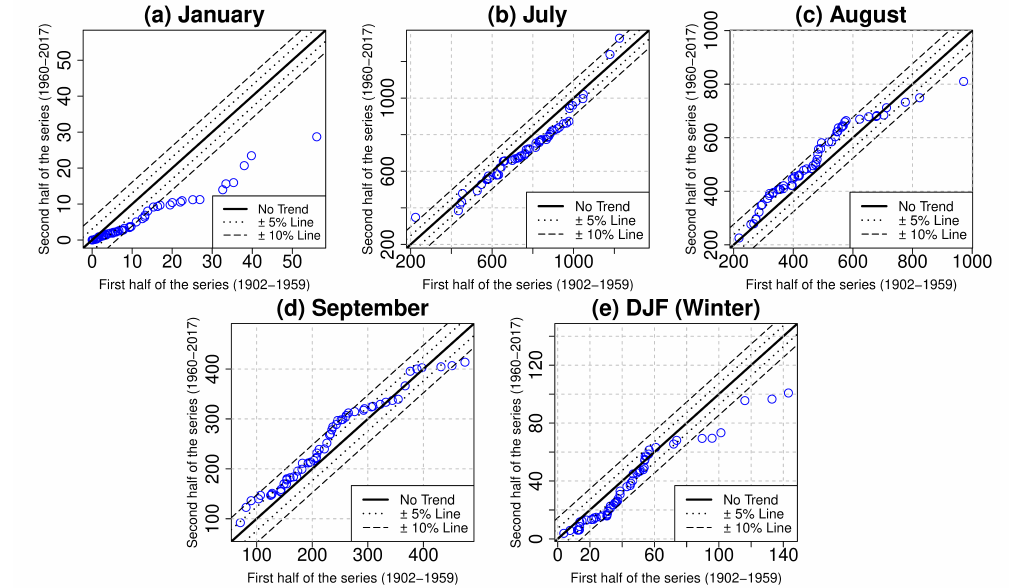
Figure 6. ( a – e ) Results of ITA method for ( a ) January, ( b ) July, ( c ) August, ( d ) September, and ( e ) Winter. X and Y-axis of the figure are representing the rainfall (in mm) for the first and second half of the whole period 1901–2017. The first half is selected as 1902–1959 by following the set convention for the case of an odd number of data points in the time series